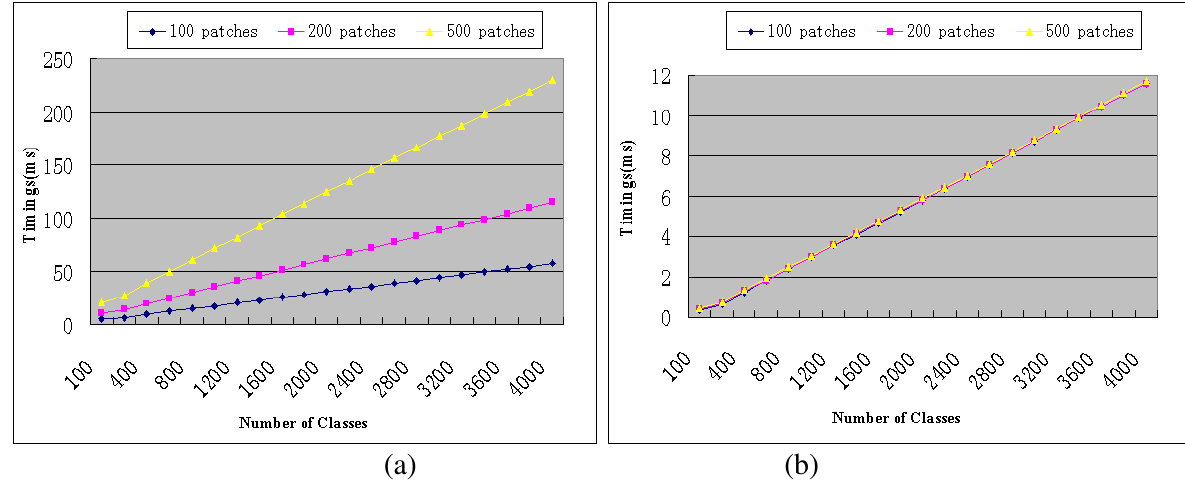
Figure 2. Comparison of the recognition timings between CPU and GPU based methods when using different number of